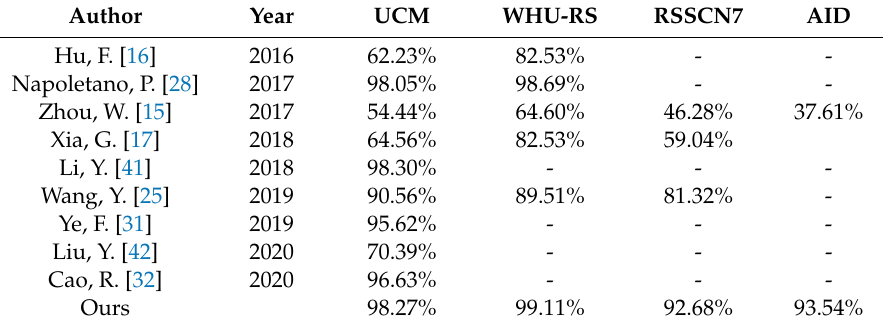
Table 6. Performance comparison with the existing